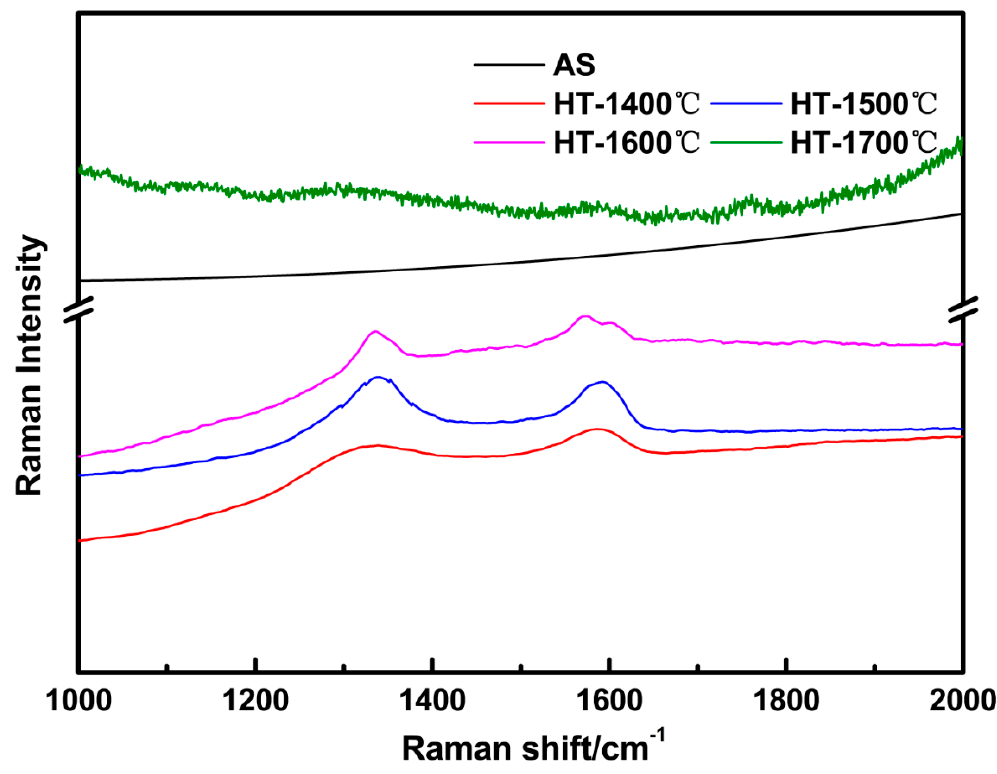
Figure 3. Raman spectra of as-received and annealed SiBCN-Si 3 N 4 ceramics at different temperatures.